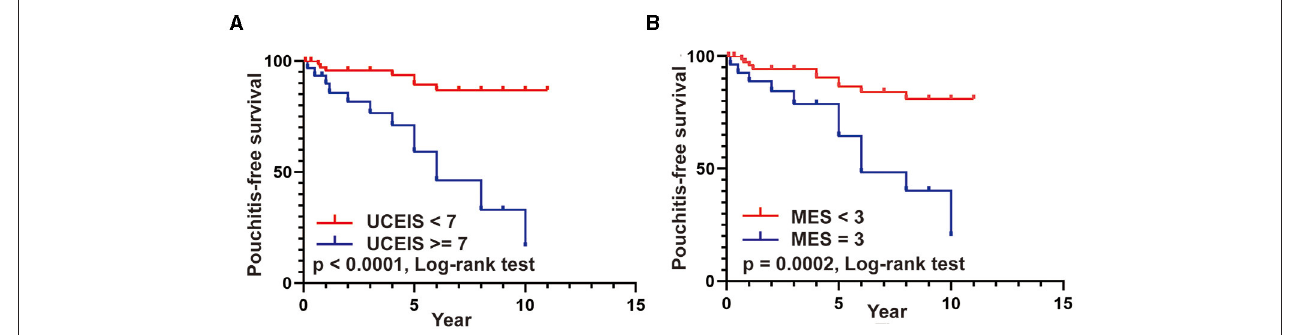
FIGURE 5 | (A,B) Pouchitis-free survival rates in patients with UCEIS ≥ 7 vs. UCEIS < 7 and MES = 3 vs. MES <